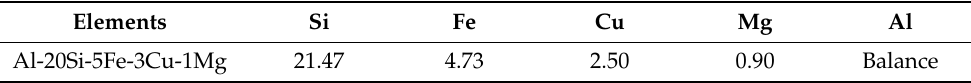
Table 1. Chemical composition of gas atomized powders (wt%).